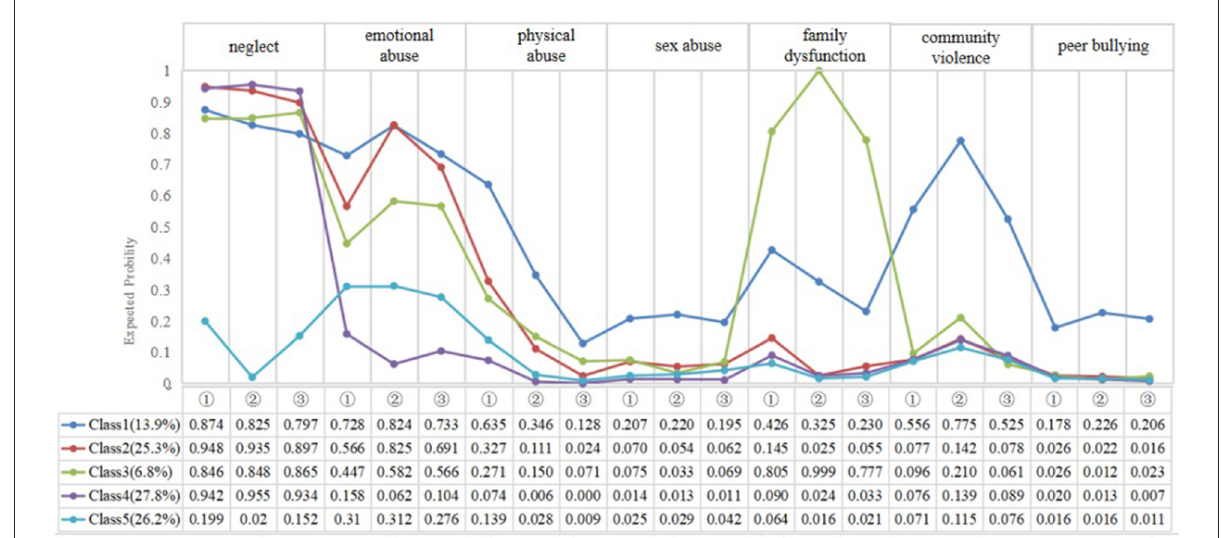
FIGURE1 Plot of 5 latent classes of adverse childhood experiences. ( 1 = Before middle school; 2 = In middle school; 3 = In high school).